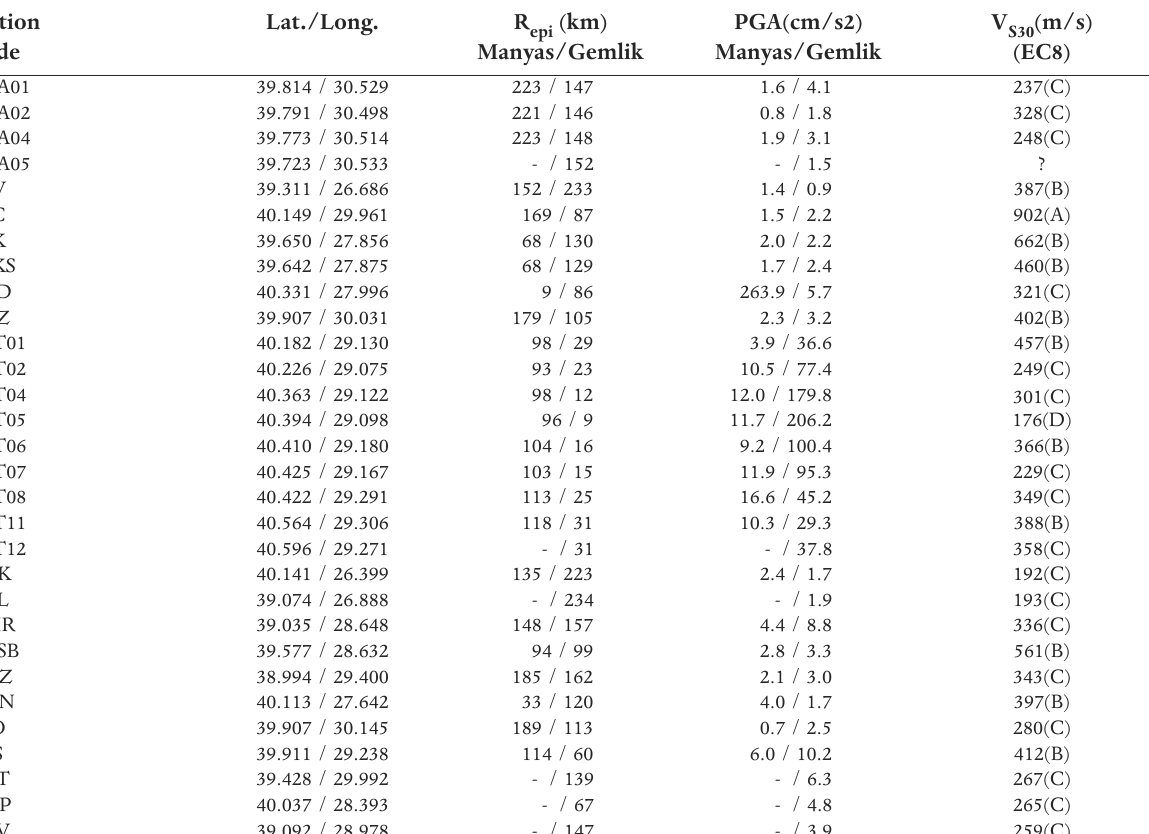
Table 2. Station parameters and peak ground accelerations (PGA) for the Manyas and Gemlik earthquakes.